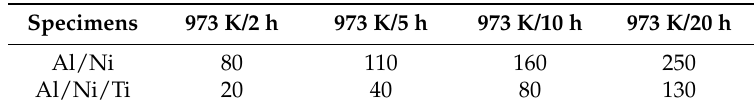
Table 4. Thickness ( µ m) of NiAl intermetallic phase with 973 K/2 h, 973 K/5 h, 973 K/10 h, and 973 K/20 h treatment of Al/Ni contrast specimens and Al/Ni/Ti